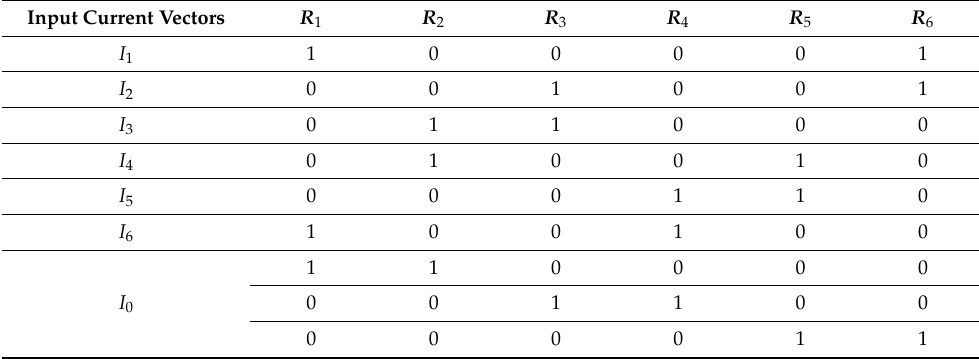
Figure 2. Input current vector. Table 1. Relationship between input current vectors and